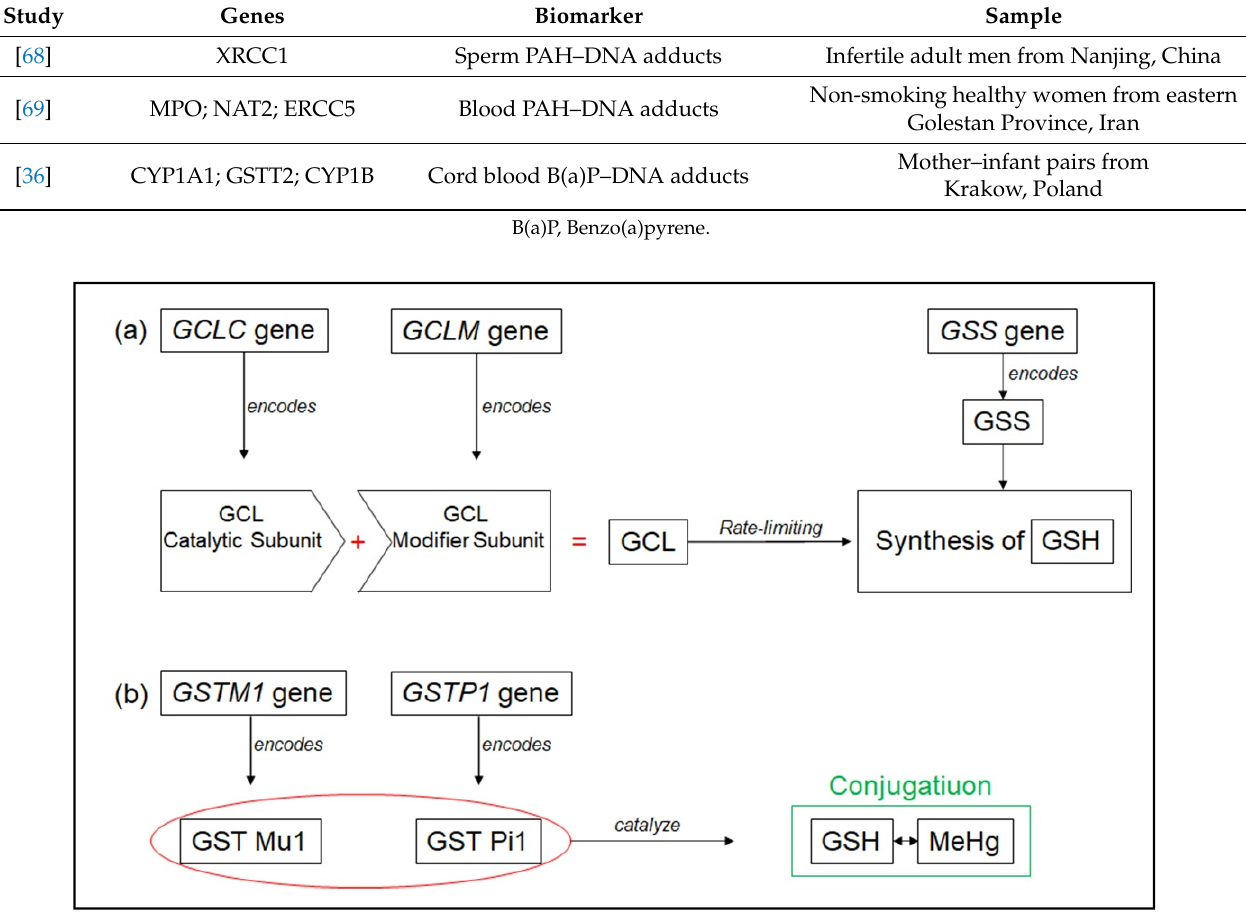
Figure 1. Schematic representation of the role played by several genes in MeHg elimination from the body. ( a ) The GCLC and GCLM genes encode the catalytic and modifier subunits of the glutamate–cysteine ligase (GCL) enzyme, respectively. The GCL is the first rate-limiting enzyme of glutathione (GSH) synthesis. The GSS gene encodes the glutathione synthetase (GSS), another enzyme involved in GSH synthesis. ( b ) The GSTM1 and GSTP1 genes encode the glutathione S-transferases (GST) Mu1 and Pi1, respectively, which catalyze the conjugation of GSH to MeHg.